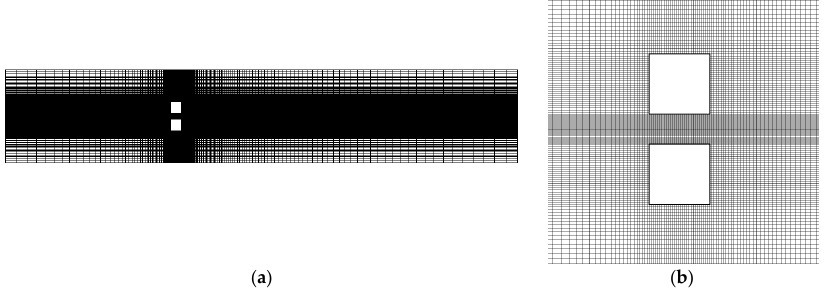
Figure 3. Mesh distribution ( a ) whole domain ( b ) near the obstacles. Table 1. The grid study at Re = 100, S/D = 1.5, d p = 30 nm, and Φ = 0.01.